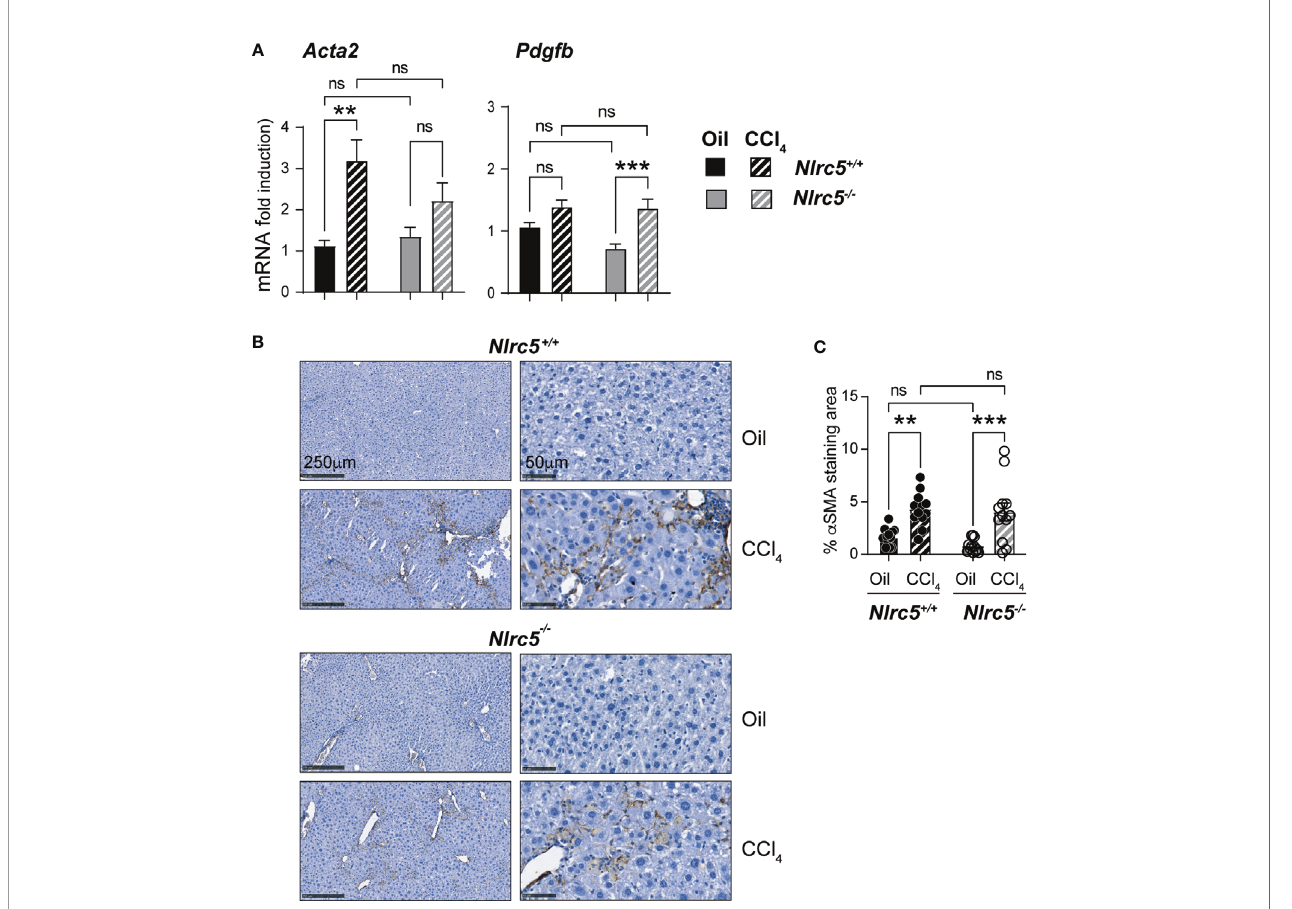
FIGURE 3 | CCl 4 -induced myo fi broblast differentiation is similar in NLRC5-de fi cient and wildtype livers. (A) Induction of Acta2 and Pdgfb genes in fi brotic livers. Quantitative RT-PCR analysis of 8-10 mice from two independent experiments. (B) Immunohistochemical staining of a SMA in oil- or CCl 4 - treated control and NLRC5-de fi cient mice livers. Representative liver sections from 4-5 mice per group from two independent experiments are shown. (C) Quanti fi cation of a SMA- stained areas. Six randomly selected fi elds from liver pieces collected from different locations of three mice per group were used for quanti fi cation. Data shown in (A, C) are mean ± SEM. Two-way ANOVA with Tukey ’ s post-hoc test: **p < 0.01; ***p < 0.001; ns, not signi fi